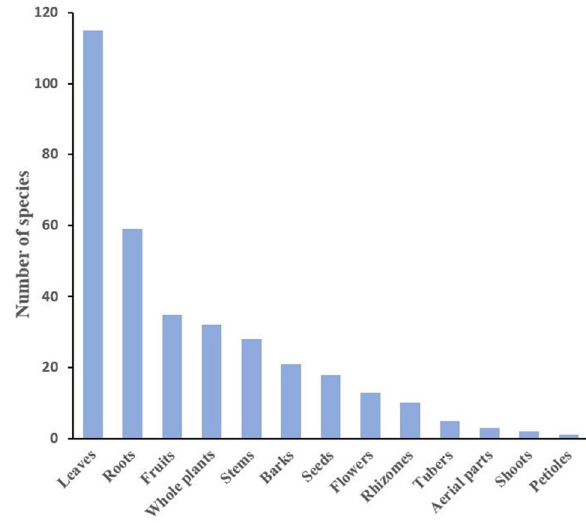
Fig. 2 List of the most frequently used plant parts along with the number of corresponding species used in ethnomedicinal